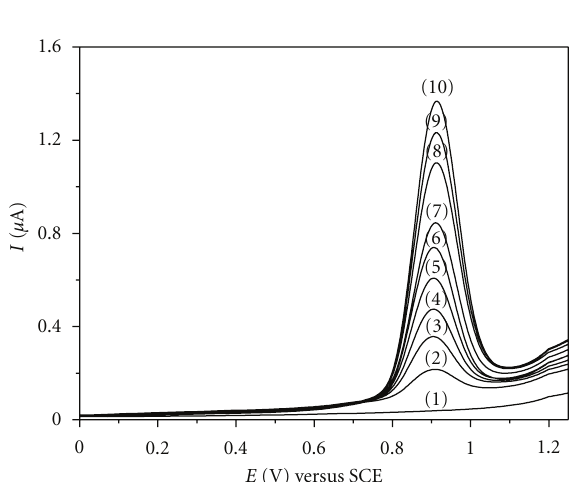
Figure 3: Di ff erential Pulse Voltammograms.E ff ect of ASA concen- tration: (1) supporting electrolyte, (2) 0.01mM, (3) 0.02mM, (4) 0.03mM, (5) 0.04mM, (6) 0.05mM, (7) 0.06mM, (8) 0.08mM, (9) 0.09mM, (10) 0.1 mM; supporting electrolyte: 0.1M Na 2 SO 4 pH